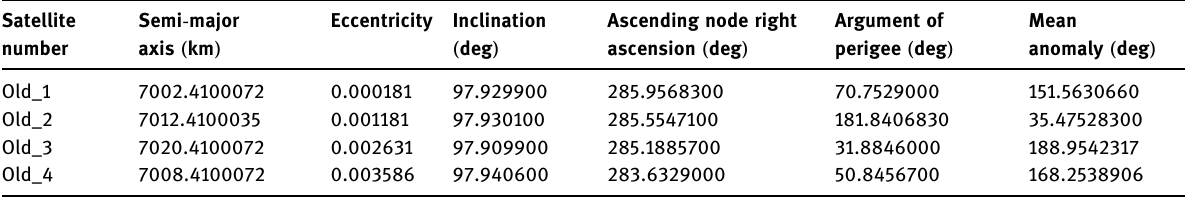
Table 2: Satellite orbit parameters covering two longitude zones of 129 and 130° Satellite